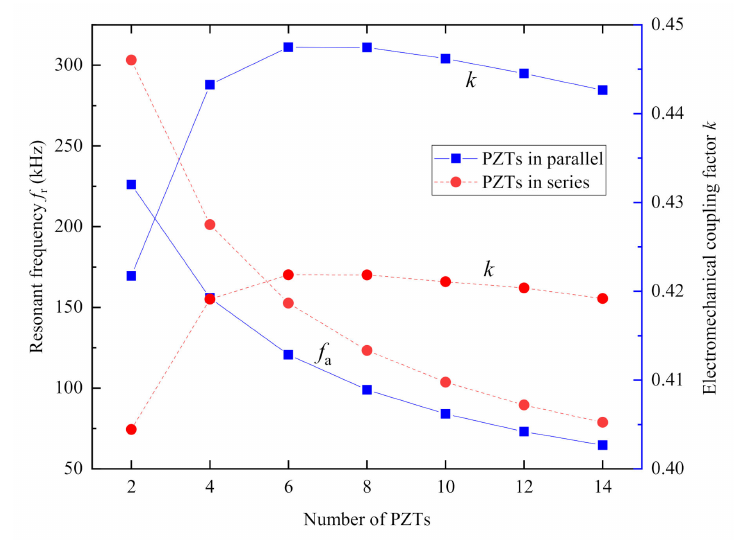
Figure 6. The first resonance frequency f r and electromechanical factor k of PiSSAs versus the number of the connected PZT wafers.